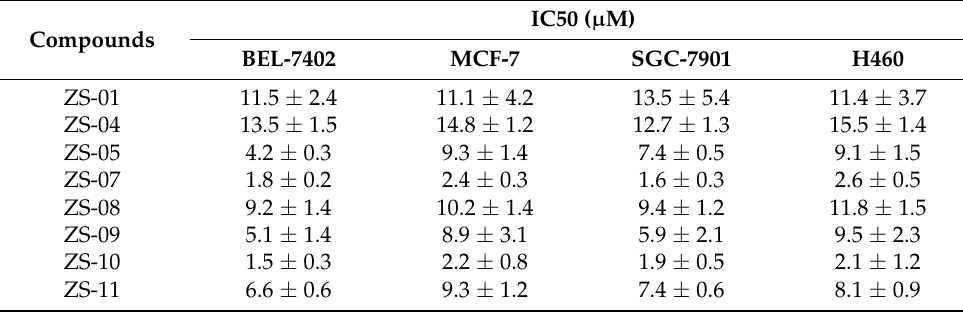
Table 1. The IC50 ( µ M) value of compounds against human tumor cell lines for 48